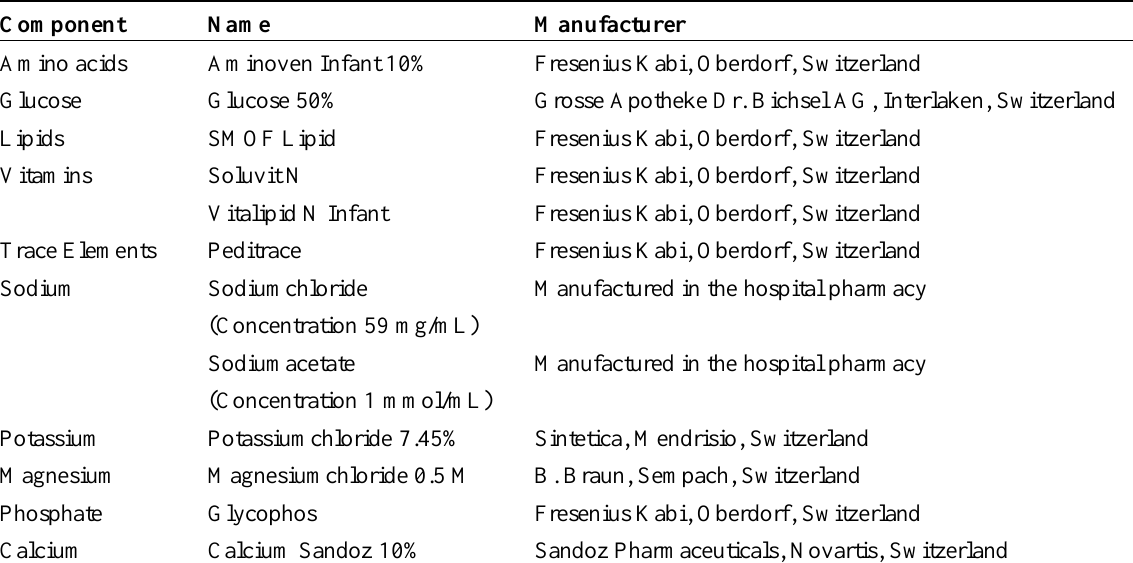
Table 1. Macro- and micro-nutrients used for the all-in-one (AIO) standard solutions.